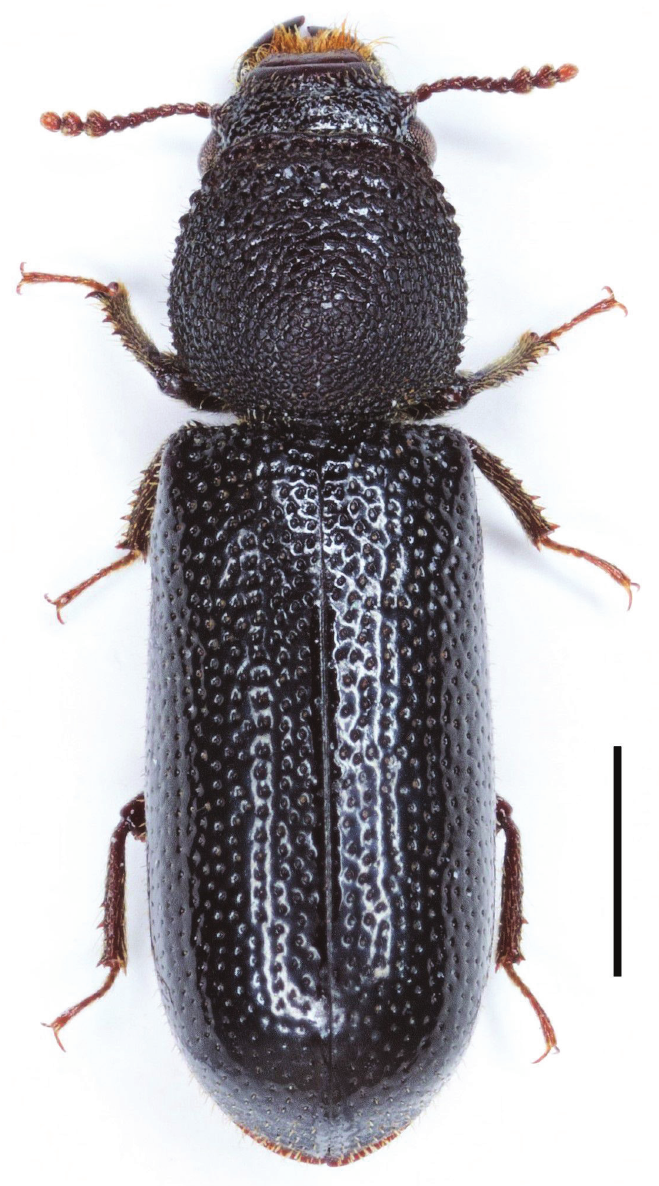
Figure 1. Stephanopachys linearis ; the specimen collected in Białowieża Primaeval Forest in 2015 – dorsal view (photo by M. Sławski, 2017). Scale bar = 1